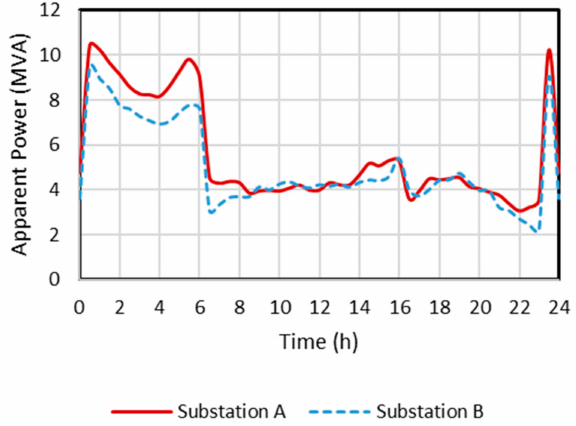
Figure 12. Apparent power flows through transformers after the introduction of DR scheme for scenario